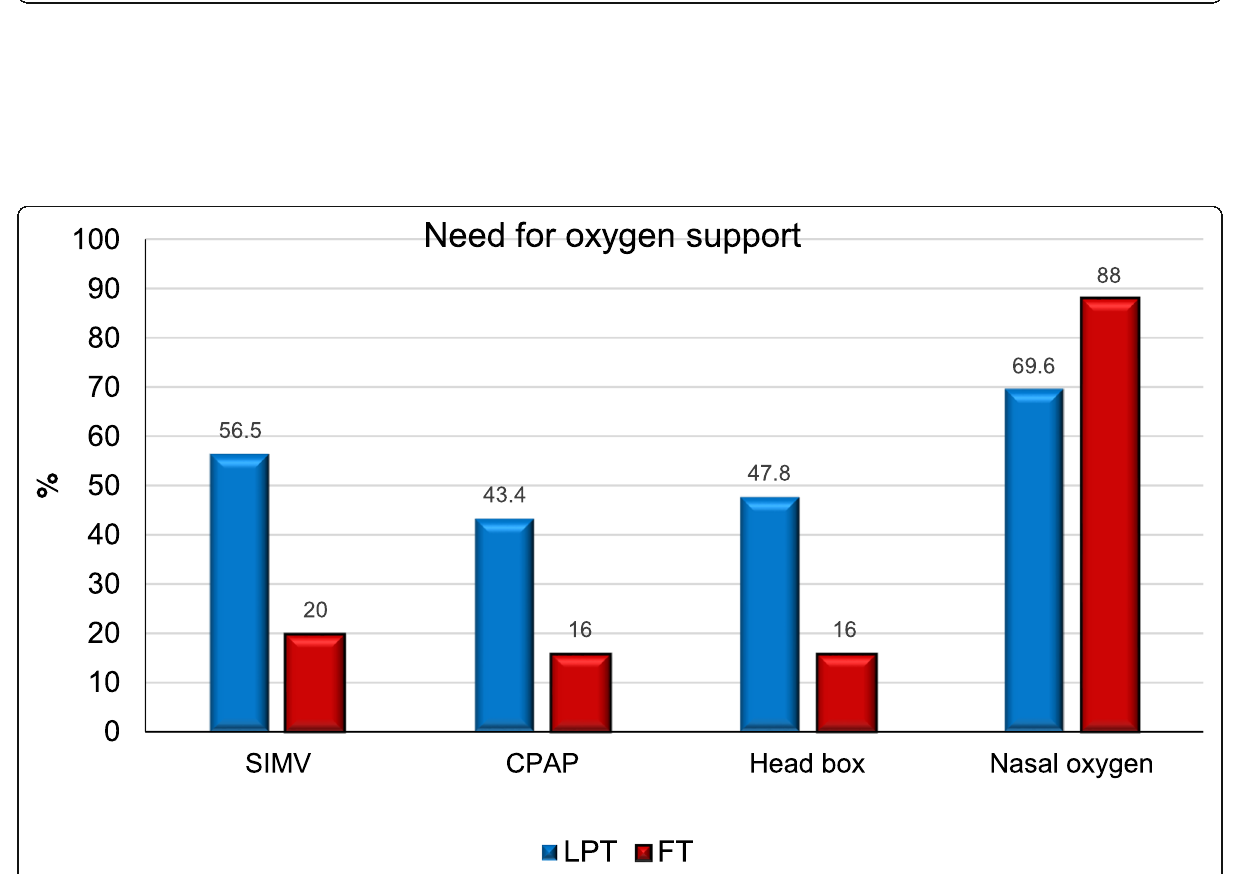
Fig. 1 Respiratory diseases in the studied groupsRDS respiratory distress syndrome, TTN transient tachypnea of newborn, MAS meconium aspiration syndrome